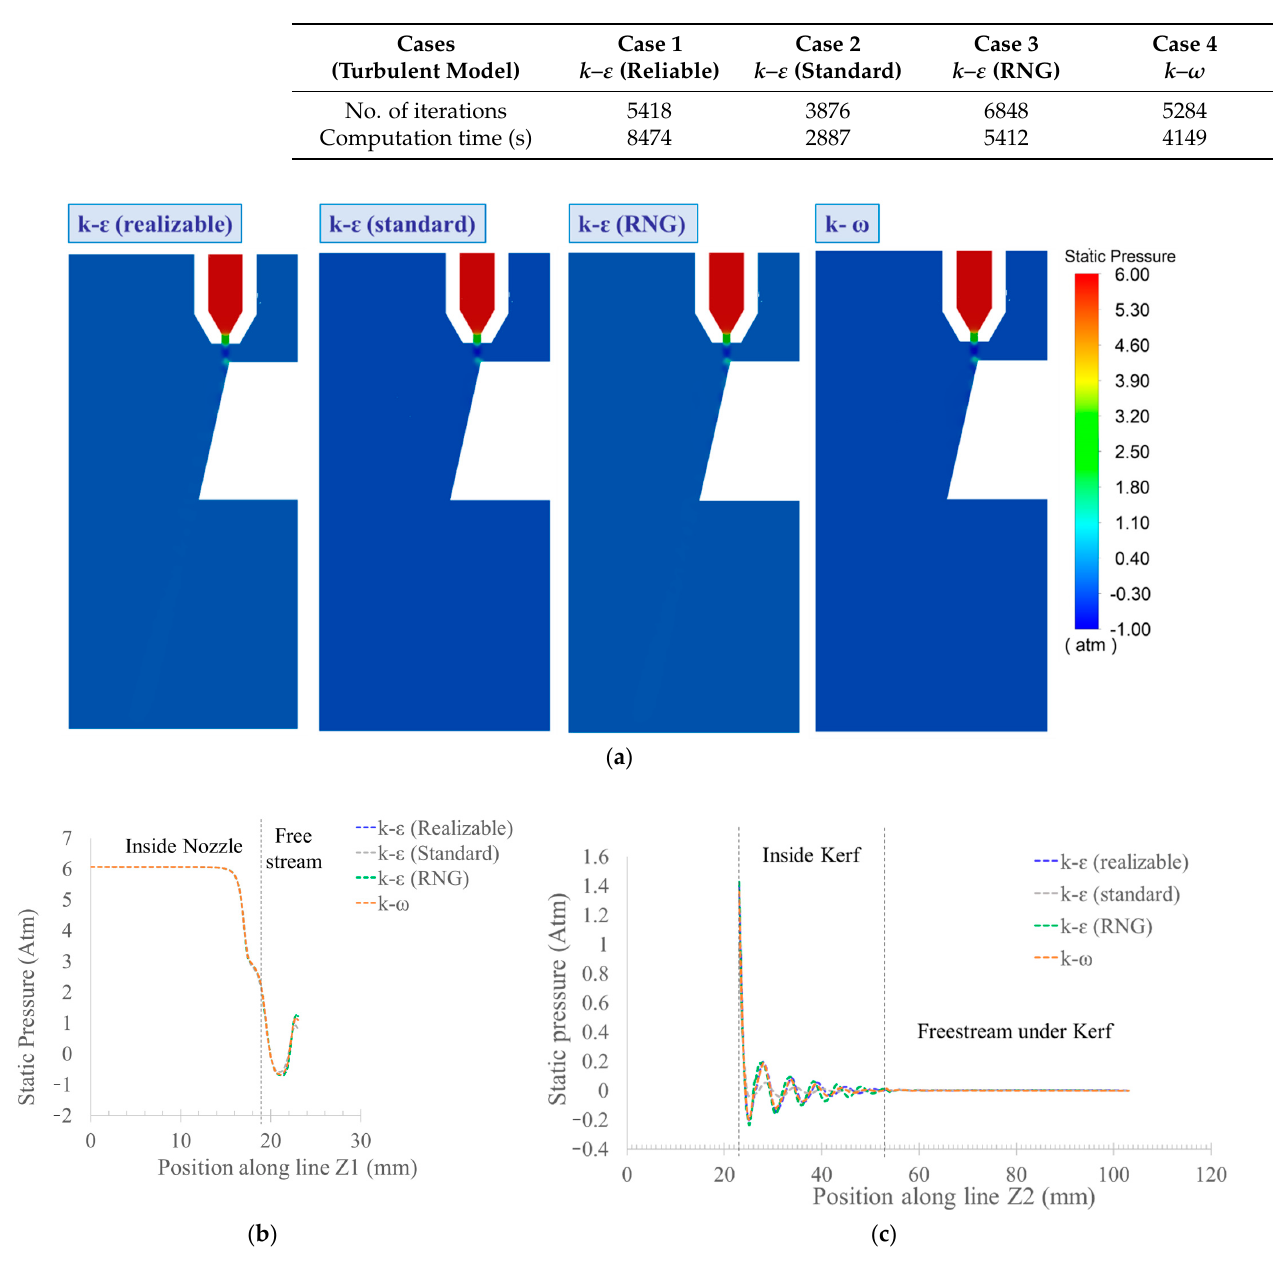
Figure 10. Pressure field. ( a ) Numerical simulation results for pressure field along the symmetry plane for four turbulent models. ( b ) Pressure distribution curve along line Z1 for four turbulent models. ( c ) Pressure distribution curve along line Z2 for four turbulent models. Table 3. Simulation cases with different turbulent models.